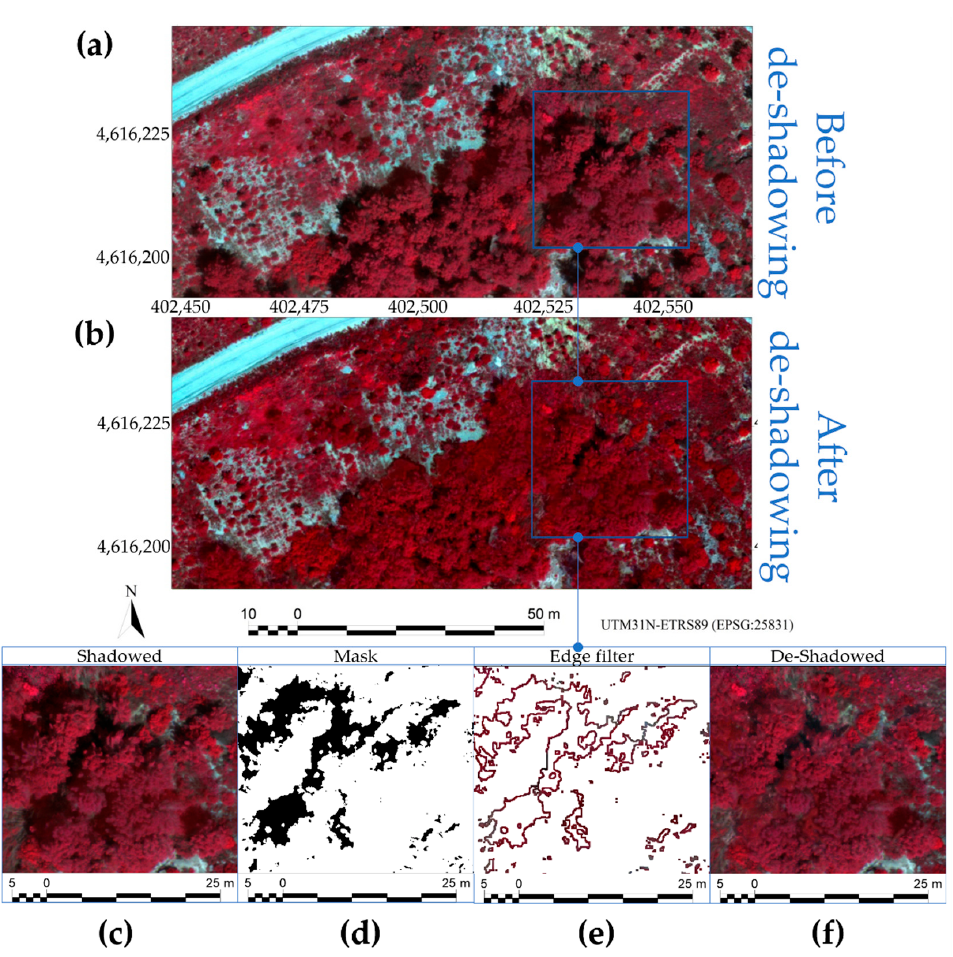
Figure 11. Results of the radiometric correction of UAV imagery using the empirical approach on shadow reduction. ( a ) At-sensor Parrot Sequoia UAV image (obtained from DLS radiometric correction) before de-shadowing. ( b ) At-surface UAV image empirically fitted to the characterized panels and empirically de-shadowed. ( c ) Detail before de-shadowing. ( d ) Detail of shadow detection results. ( e ) Detail of edge filtering results. ( f ) Detail of the image after de-shadowing.